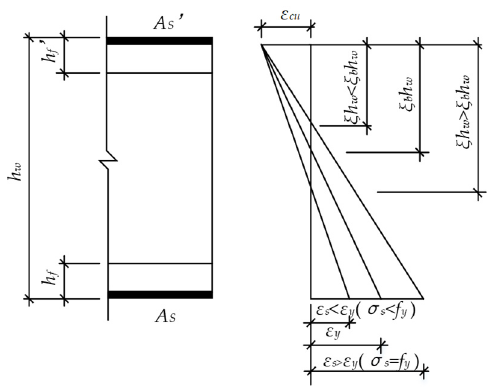
Figure 7. The strain distribution of the SC walls.